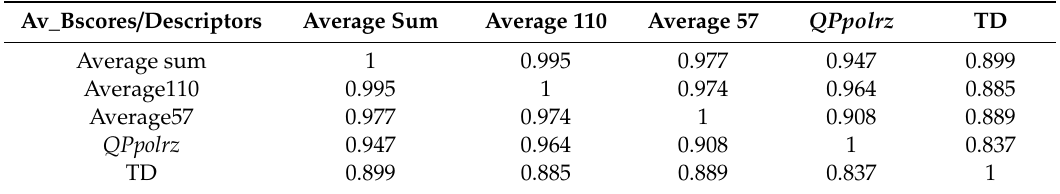
Table 2. The correlation between Average sum, Average 110, Average 57, polarizability ( QPpolrz ), and topological diameter ( TD )